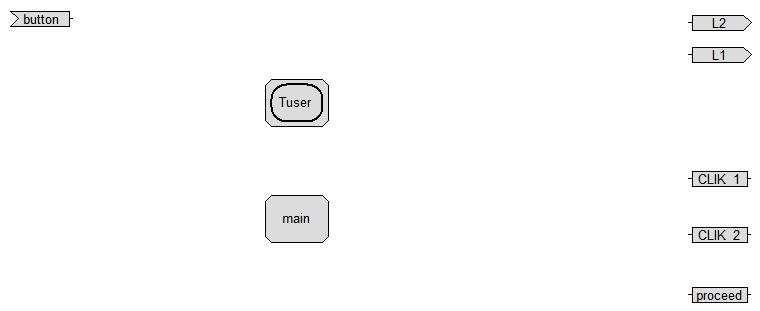
Figure 15. Context Diagram of the Lights example.